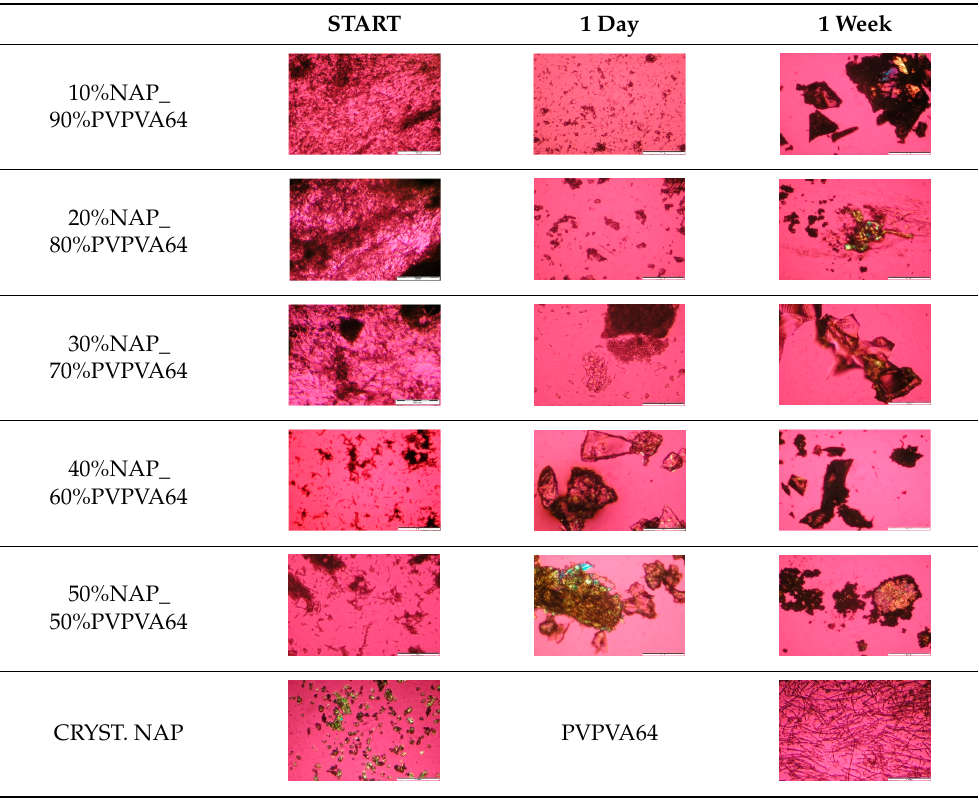
Figure 13. Dissolution results of the prepared ASDs. Applied parameters: 37 ± 0.5 °C, 900 mL of 0.1 M HCl dissolution medium, 50 mg of the API content, “tapped basket” method, 50 rpm, n = 3.